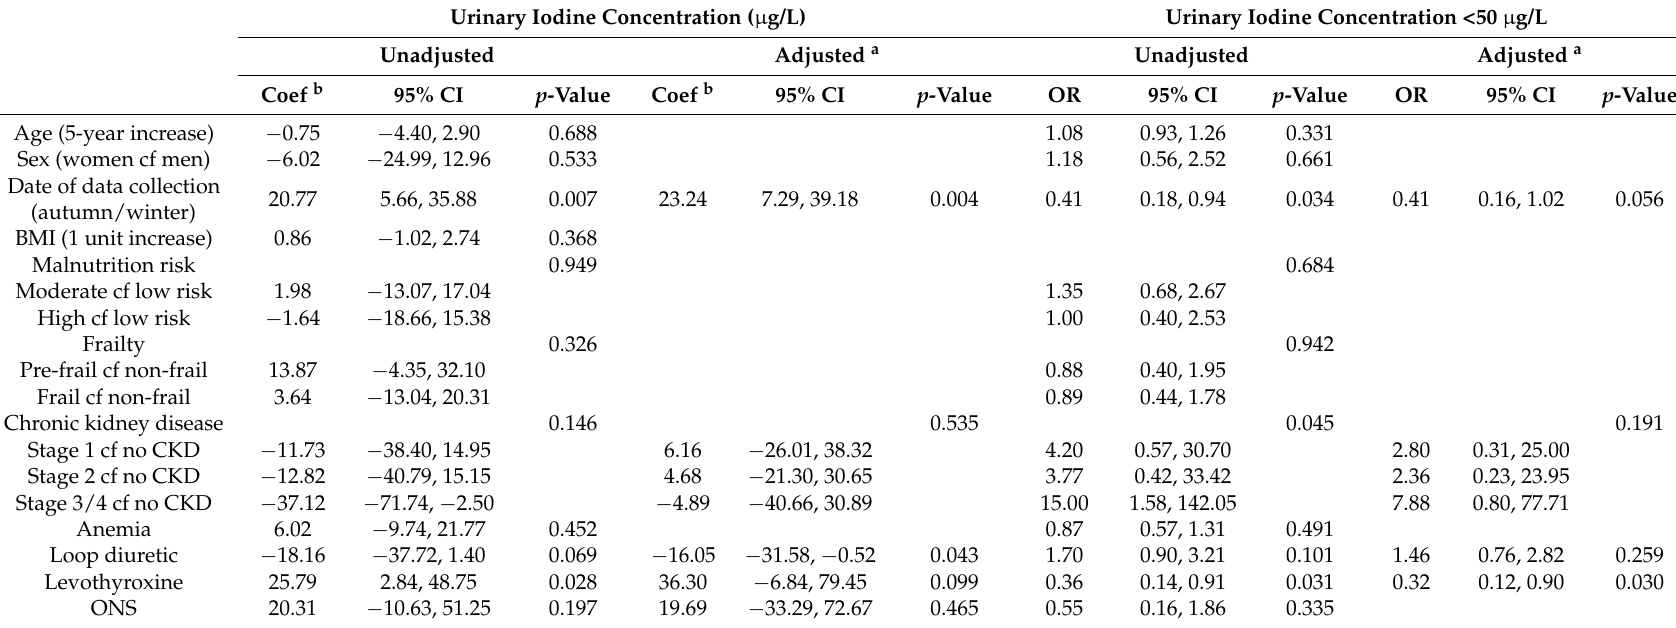
Table 3. Predictors of urinary iodine concentrations of New Zealand rest home residents